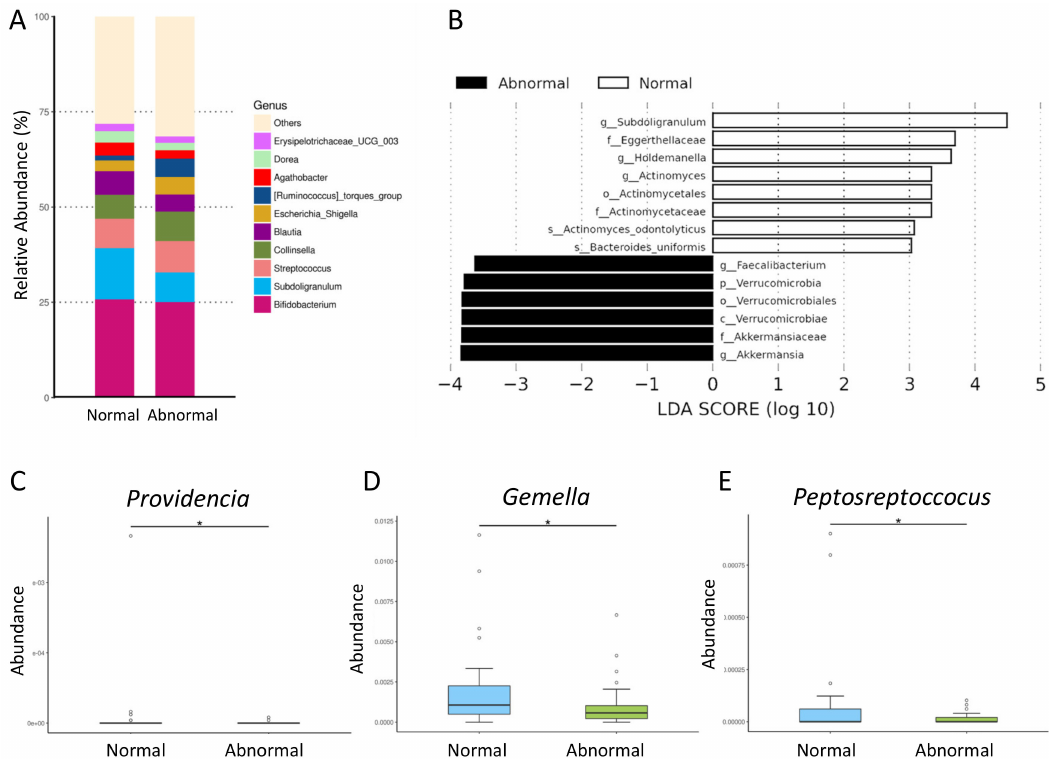
Figure 3. ( A ) Relative abundance of top 10 genera of the gut microbiota in CKD children with normal and abnormal ABPM group. ( B ) Linear discriminant analysis e ff ect size (LEfSe) to identify the taxa that were significantly di ff erent between normal vs. abnormal ABPM group. The threshold of the linear discriminant was set to 3. ( C ) The abundance of genus Providencia , ( D ) Gemella , and ( E ) Peptosreptoccocus in CKD children with normal vs. abnormal ABPM. The asterisk indicates p <